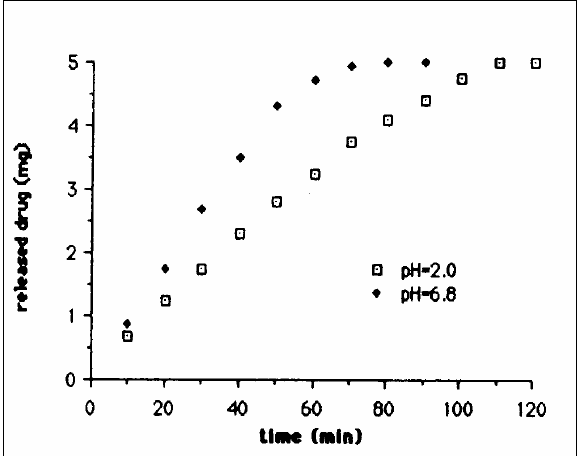
Figure 4. Cumulative amount of TPH released as a function of time. Experiments were performed at pH=2.0 and 6.8 (each tablet contained 5 mg of TPH and 100 mg of the Sclg